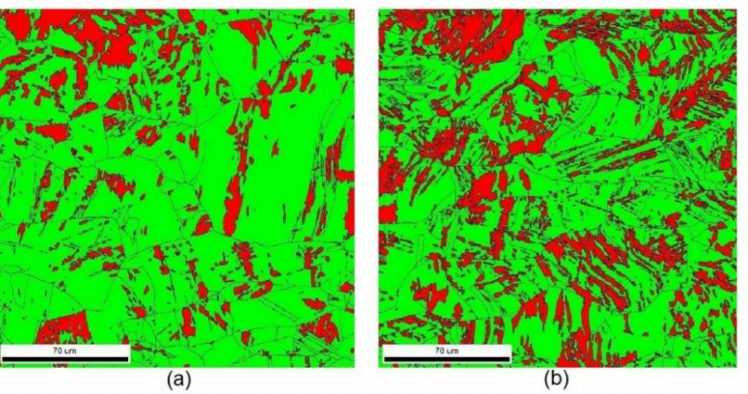
Figure 4. Electron backscattered diffraction (EBSD) phase maps for the different plastic strains, austenite—green colour, martensite—red colour. ( a ) ε = 35%, ( b ) ε =